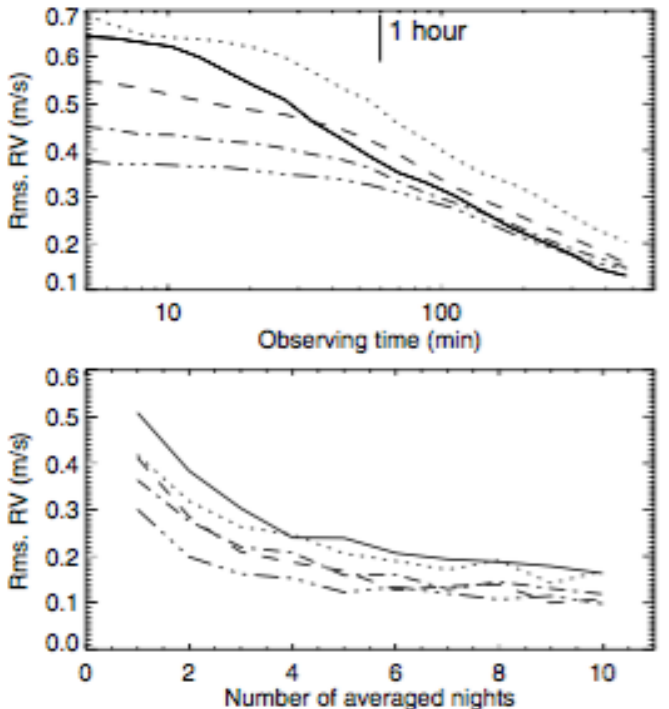
Figure 6. Subset of Figure 13 from [66] showing the residual rms after smoothing granulation noise over various amounts of observing time in a given night, with 1–5 different measurements per night (top; 1: smooth, 2: dotted, 3: dashed, 4: dot-dashed, 5: dot-dot-dot-dashed). Also shown is the impact of binning all observations in 1–10 consecutive nights, if the total observing time in a night were 26